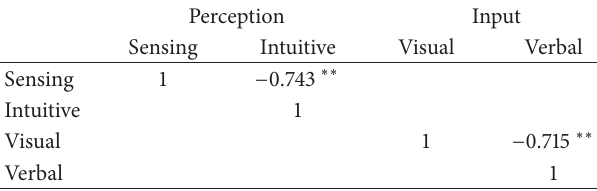
Table 7: The interrelationships of learning style dimension. Perception Input Sensing Intuitive